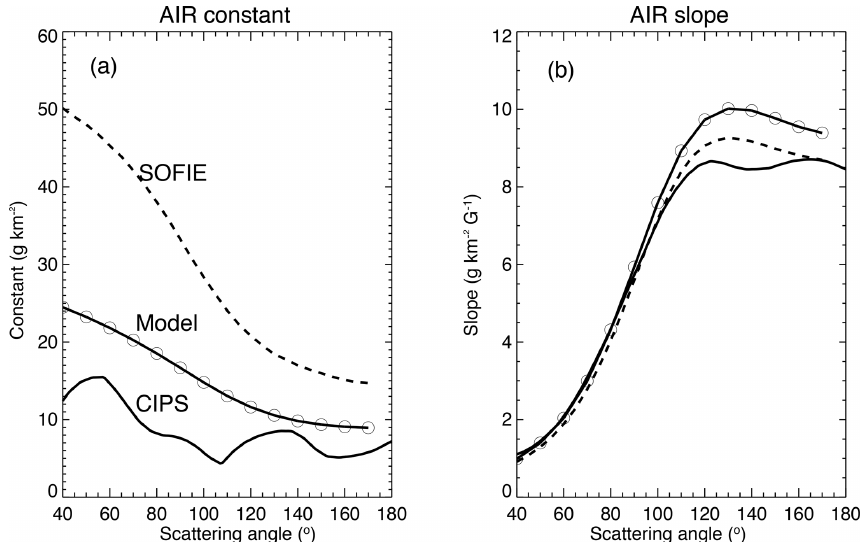
Figure 9. AIR coefficients for three different sources of IWC and particle size: model (solid line with open circles), CIPS (solid line), and SOFIE (dashed line).